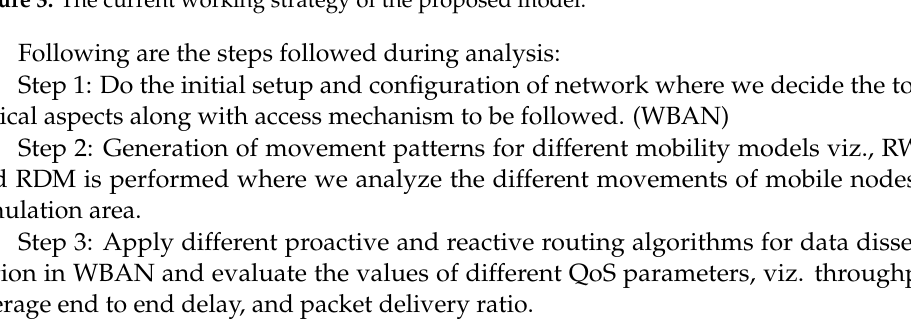
Figure 3. The current working strategy of the proposed model.